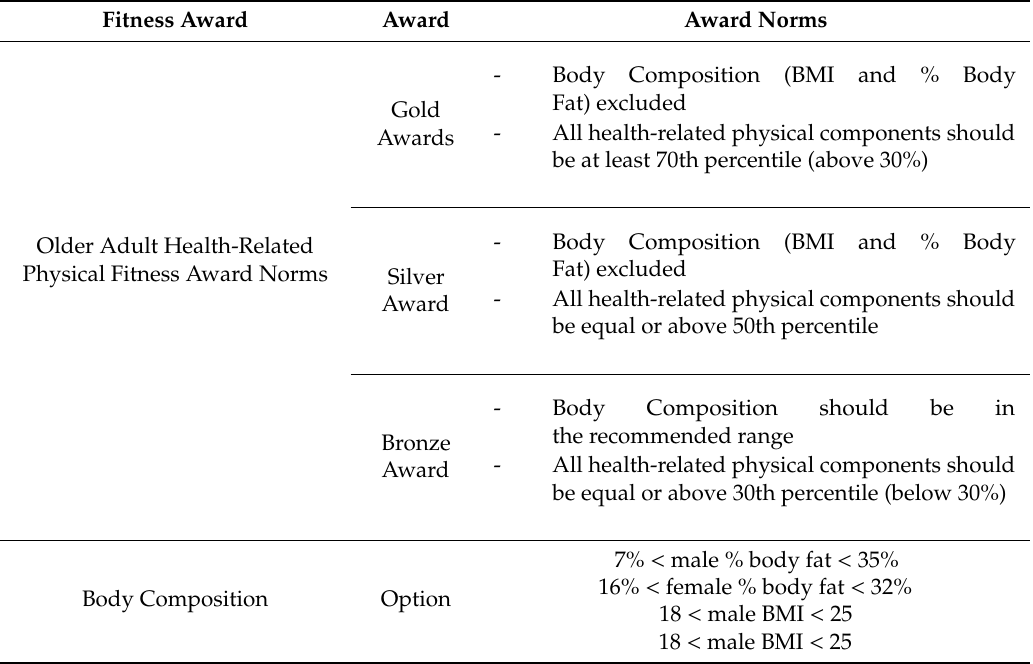
Table 20. Older adult health-related fitness award